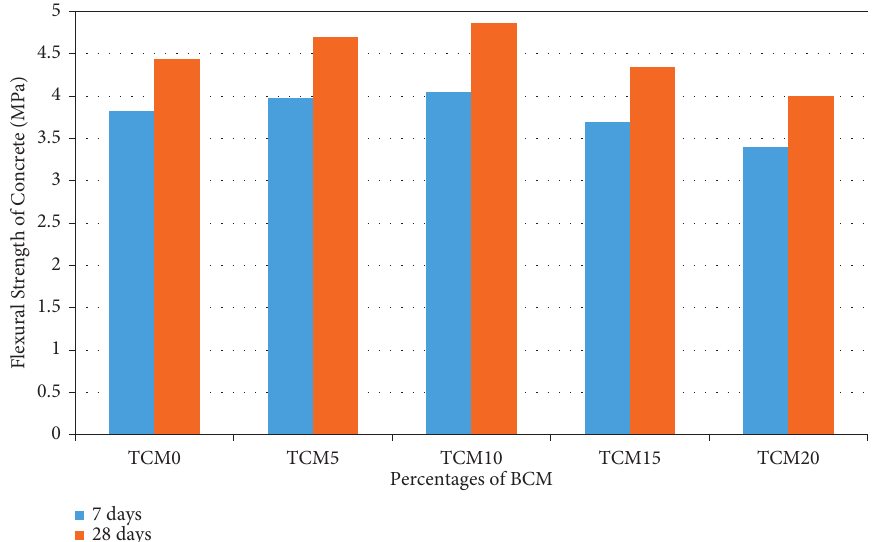
Figure 10: Flexural strength of